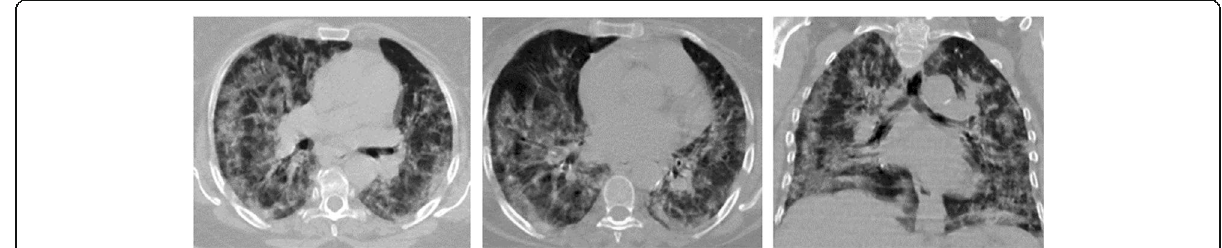
Fig. 5 Male patient, 60 years old, was complaining of dry cough and dyspnea and was confirmed to be COVID-19 by RT-PCR. These axial and coronal non- contrast CT chest images (lung window) show typical findings with high suspicion of COVID-19 pneumonia in terms of diffuse multifocal ground-glass opacities involving both lungs with CORADS-3. Both upper and lower lobes have a score of 5 (with ≥ 75% involvement), while the middle lobe has a score of 4 with (50% to < 75 % involvement), so the total CT lung severity score is 24 with 96% of lung involvement denoting severe grade of lung affection